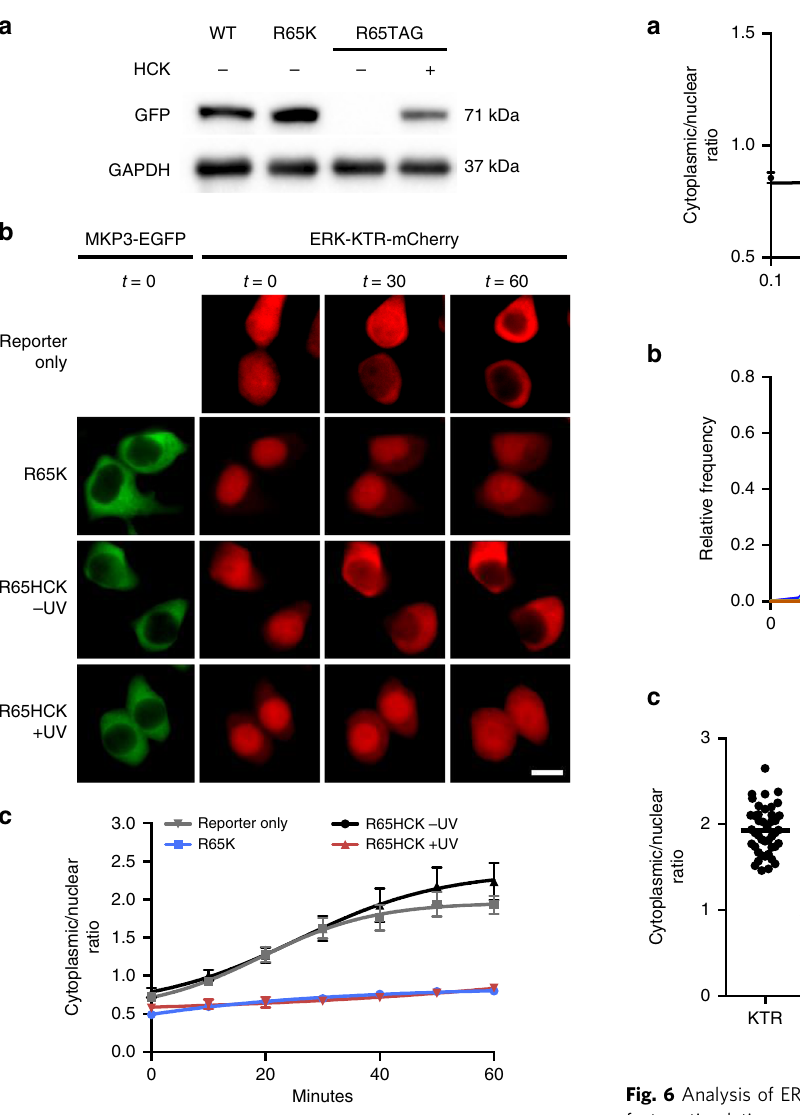
Fig. 5 ERK activity in response to optical activation of the MKP3 kinase interaction motif. a Western blot of wild-type, R65K, and caged MKP3 shows full-length expression only in the presence of 0.25 mM HCK. b KIM-caged MKP3 cannot ef fi ciently bind to and dephosphorylate pERK until UV irradiation (365 nm, 2 min) generates an active enzyme. Scale bar